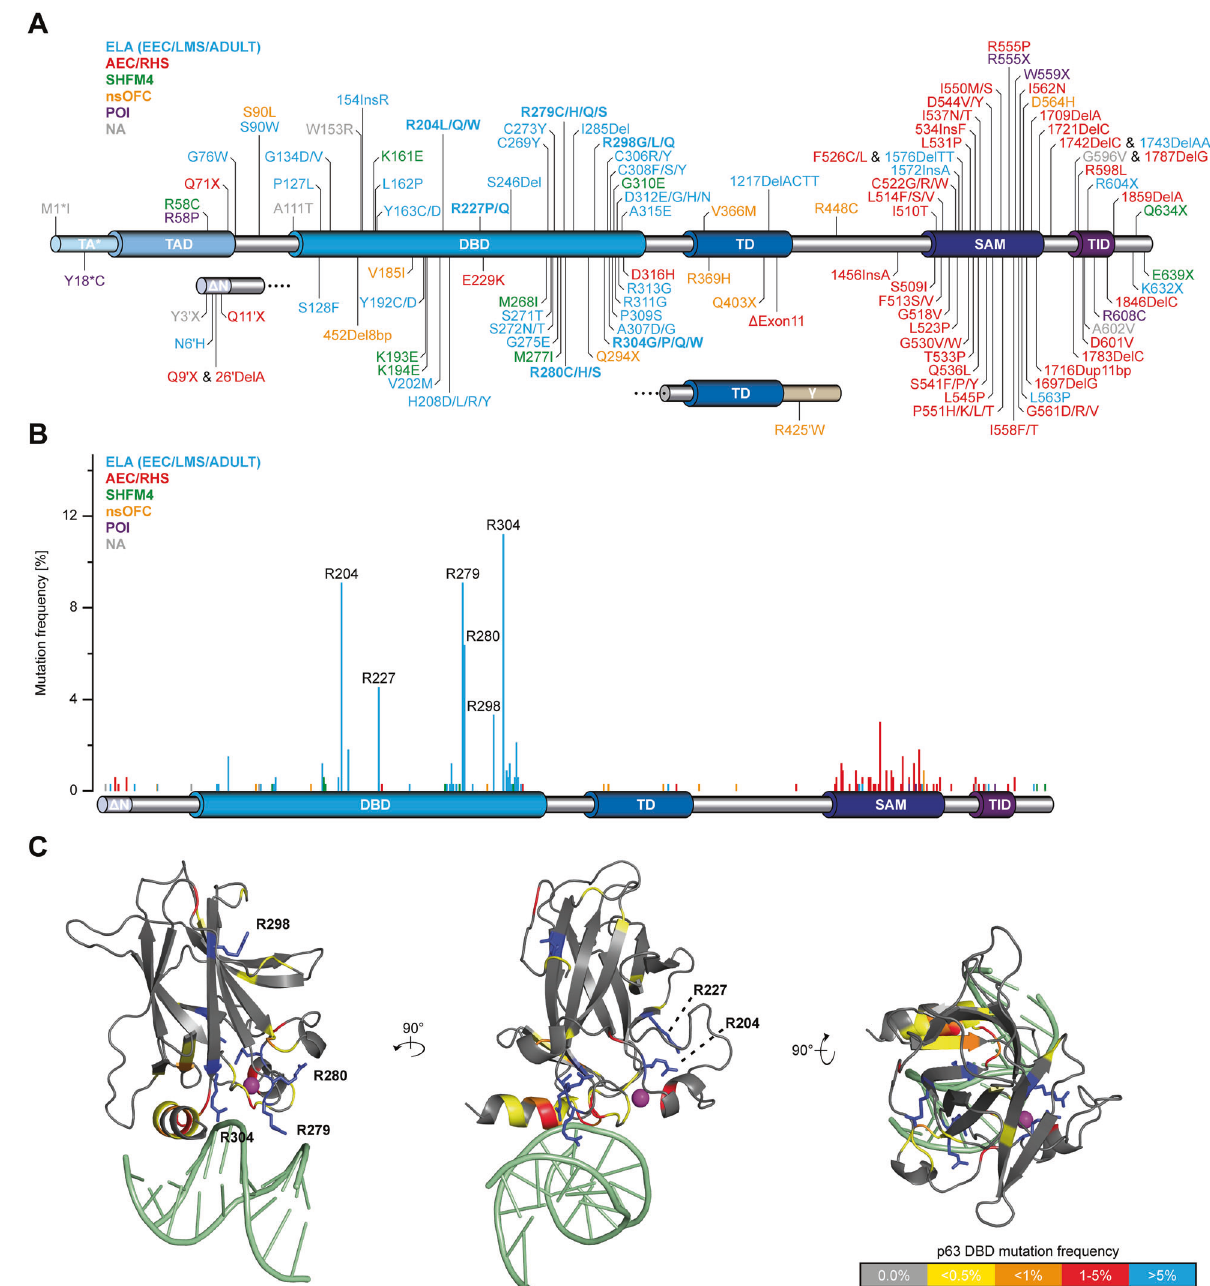
Fig. 1 Analysis of reported disease-related p63 mutations. All published case reports of human developmental diseases linked to p63 mutations were extracted and evaluated (Supplementary Table S1). A An overview of the p63 mutation spectrum was generated by plotting position of all mutations on schematic domain architecture of p63. Each mutation is colour coded according to the predominantly caused developmental disease. B The extracted data was analysed for frequency of mis- and nonsense mutation occurring for each residue in p63 ( n = 332 families). Frameshift mutations and gene deletions were disregarded due to their rare incidence. Mutation frequencies are plotted as bars along the p63 protein sequence aligned to the schematic domain architecture. Each bar is colour coded corresponding to the developmental disease the mutation of the respective residue is predominantly causing. The positions of the six mutational hotspots R204, R227, R279, R280, R298 and R304 are highlighted with labels. C Mutation frequency was calculated for the p63 DBD individually ( n = 202 families) and blotted with the indicated colour code on the DBD structure (PDB: 3QYN). The six mutational hotspots are depicted as sticks and highlighted with labels. DNA is shown in light green and the zinc ion as a purple sphere. A , B TA*: TA*p63 isoform-speci fi c N-terminus; Δ N: Δ Np63 isoform-speci fi c N-terminus; TAD Transactivation domain; DBD DNA binding domain; TD tetramerization domain; SAM sterile- α -motif domain; TID transcriptional inhibitory domain; γ : p63 γ isoform-speci fi c C-terminus. nsOFC non ‐ syndromic orofacial clefting; POI premature ovarian insuf fi ciency; NA not assigned to any of the known mutant p63-related diseases.